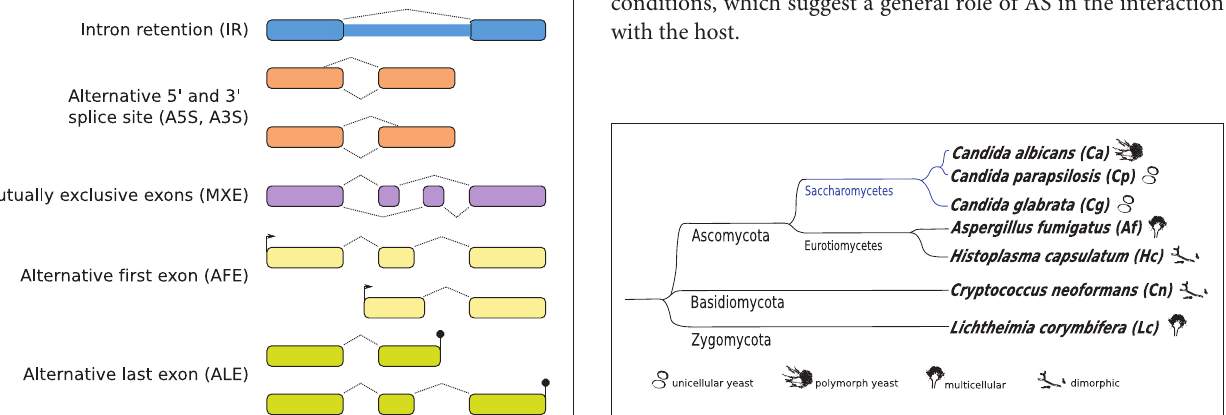
FIGURE 2 | Phylogenetic tree of studied fungal species with corresponding morphology (Stajich et al., 2009). The branch of the studied Candida species is marked in blue to recognize the phylogeny in the following